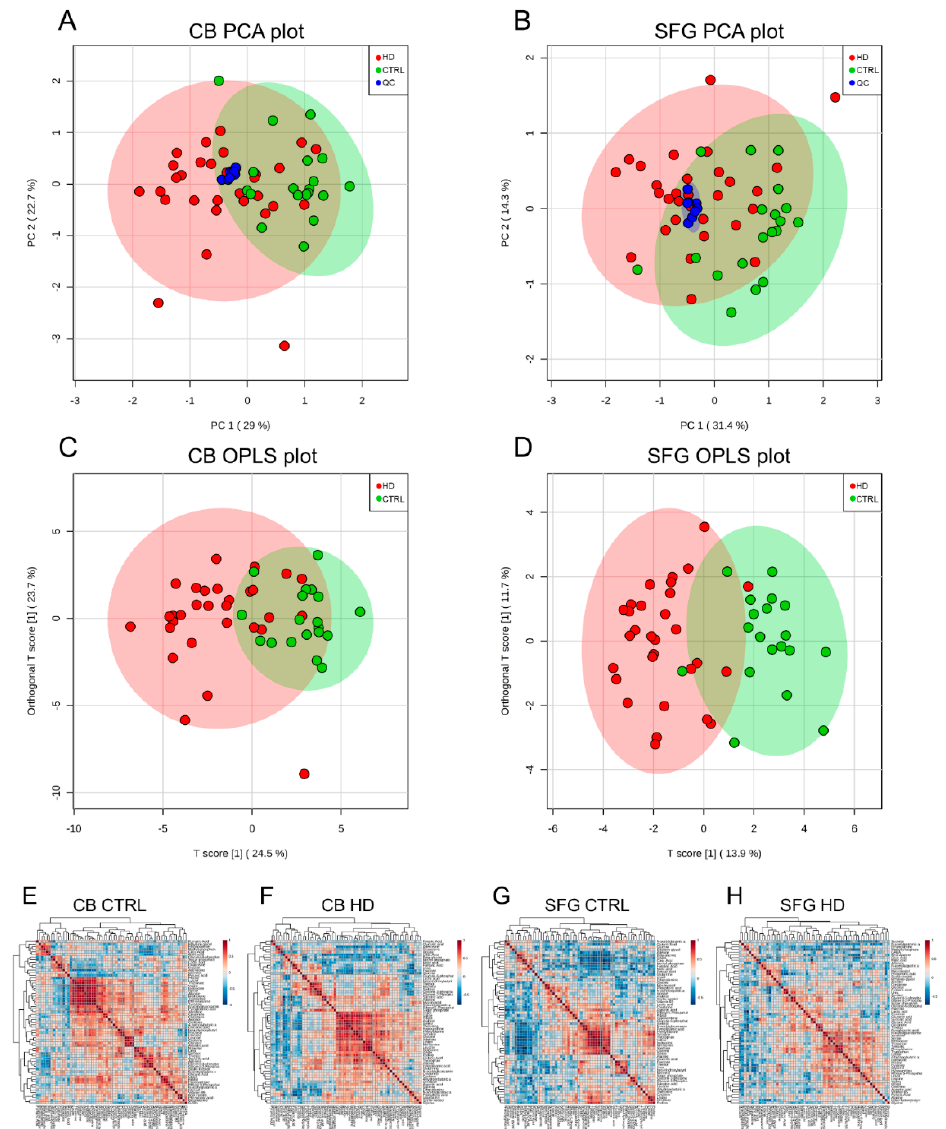
Figure 2. Shown are PCA, OPLS-DA, and hierarchical correlation heatmaps of CB and SFG brain samples analysed by GC-MS. ( A,B ) PCA plots showing limited class separation in CB and SFG brain areas between HD cases (red circles) and controls (green circles). In CB samples, the first principal component (PC 1) explains 29.0% of the total variance in the subjects examined, the second (PC2) an additional 22.7%. In SFG the PC1 represents 31.4% of the total variance whereas PC2 contributes 14.3%. The different conditions (HD vs. controls) can only be partially separated in the PCA plots. The compact clustering observed between the QC replicates (blue circle) supports the high degree of reproducibility of the GC-MS assay used here. ( C,D ) OPLS-DA model results for CB and SGF brain regions in HD (red circles) and controls (blue circles). Limited separation is observed between HD cases and controls in both brain regions analysed by GC-MS. Coloured ellipsoids around each group represent 95% confidence intervals. ( E–H ) Hierarchical correlation heatmaps illustrating the differential clustering and metabolite abundance co-regulation in CB (left panels E, F) and SFG (right panels G, H) in controls and HD mutation-carriers. Metabolites were clustered with a Euclidean distance algorithm and differences between co-regulation of metabolite abundances were investigated by Pearson correlation analyses. Pearson’s correlation coefficient ( r ) values are visually depicted in the colour gradient scales on the right side of each heatmap.